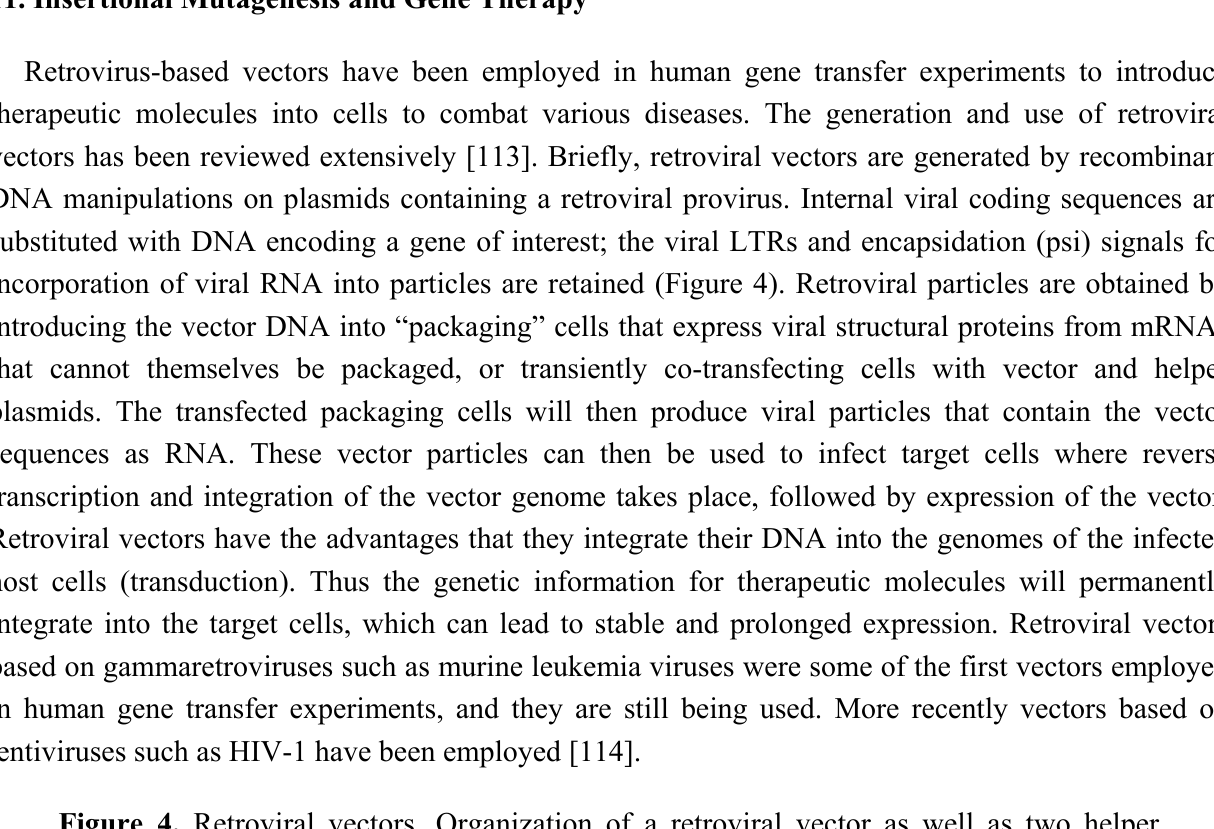
Figure 4. Retroviral vectors. Organization of a retroviral vector as well as two helper plasmids to produce the viral proteins are shown. Ψ , the packaging sequences on viral RNA. In some cases the helper plasmids are stably expressed in a packaging cell, or in other cases they are co-transfected with the vector